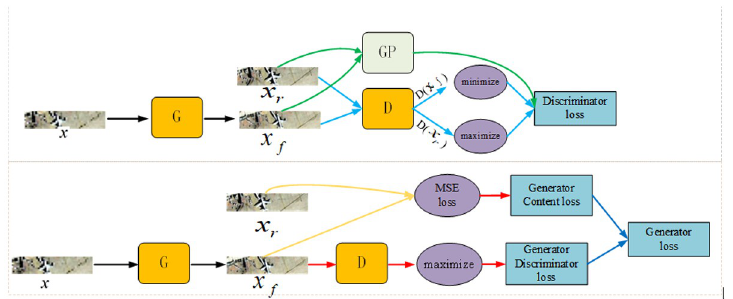
Fig 4. Visualization of our loss of function. The upper part of the figure is the loss function flow of the discrimination network; The next part is the loss function flow of the generated network.